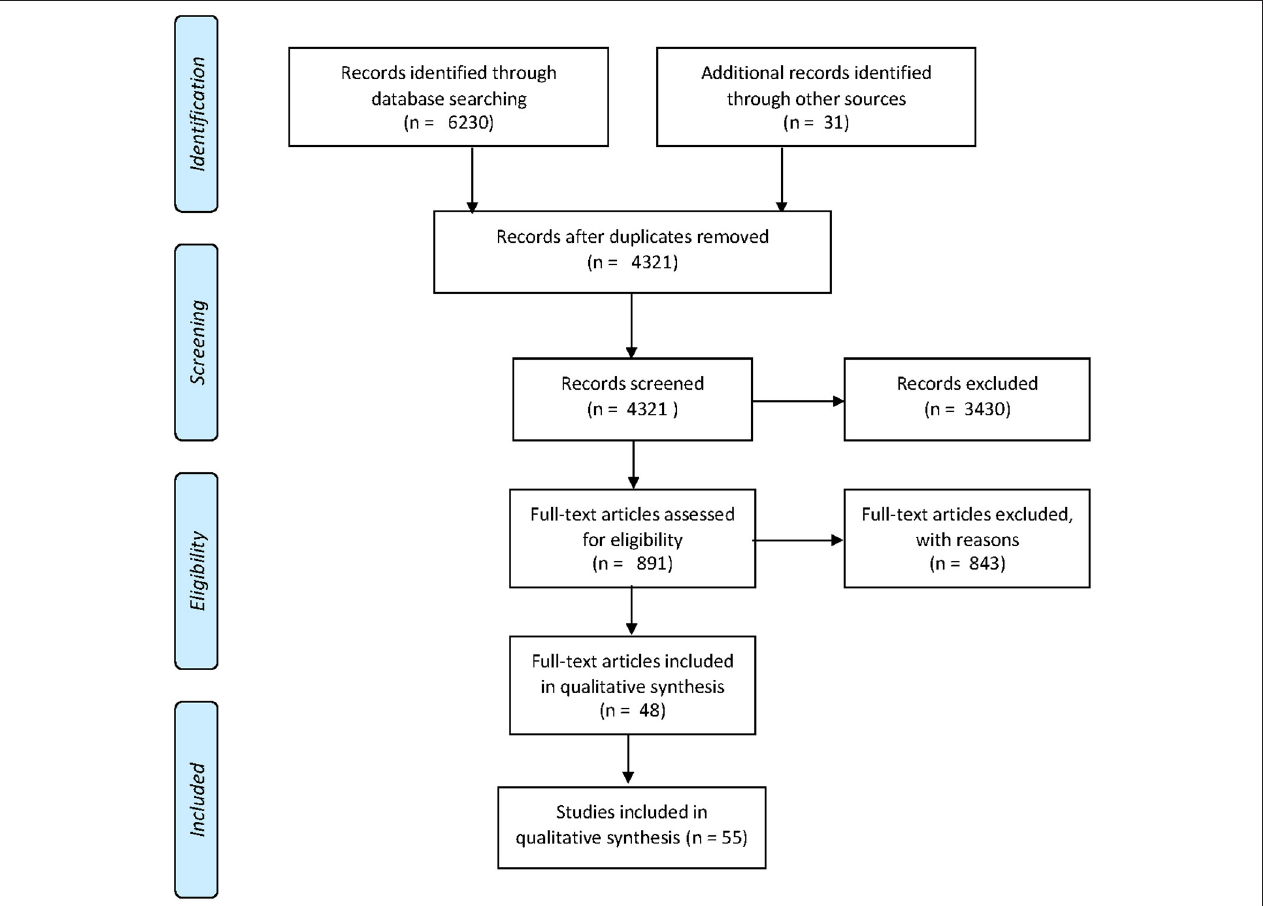
FIGURE 1 | Review flowchart: a flowchart of the screening and inclusion of articles in our systematic